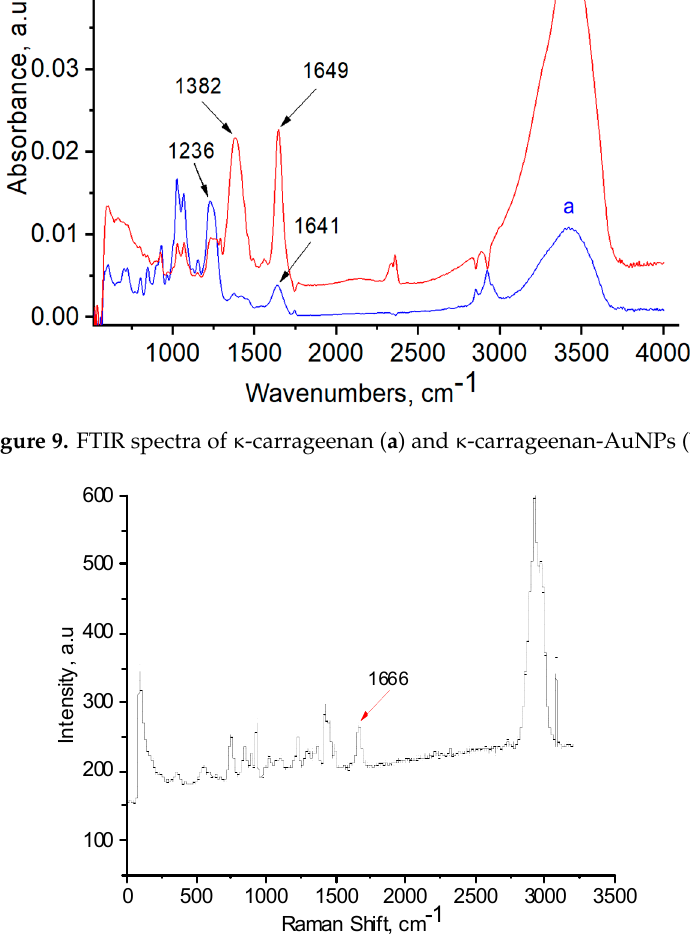
Figure 10. Raman spectrum of PVP 40.